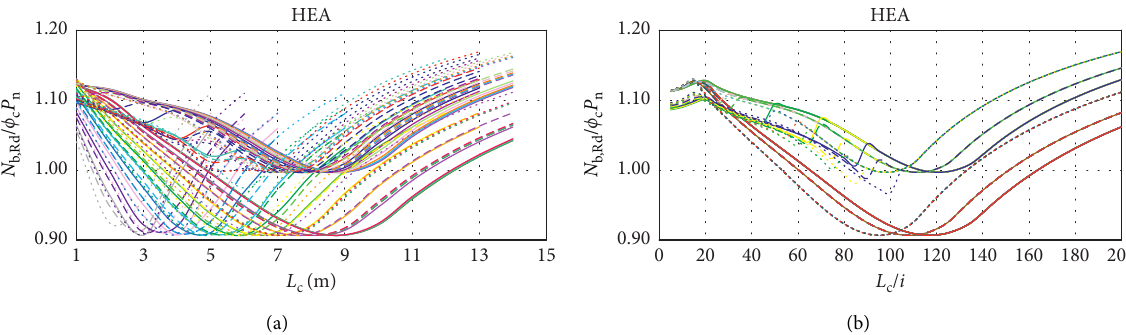
Figure 10: Variation of capacity ratio with buckling length L c (a) and with member slenderness L c / i (b) for studied HEA members. In each plot, the solid, dashed, and dotted curves with identical colours represent the capacity curves plotted for a particular section when the steel grades are S235, S275, and S355,